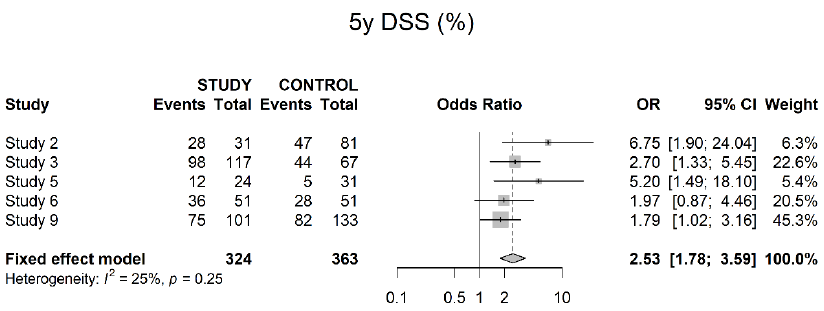
Figure 13. Five-year disease-specific survival.